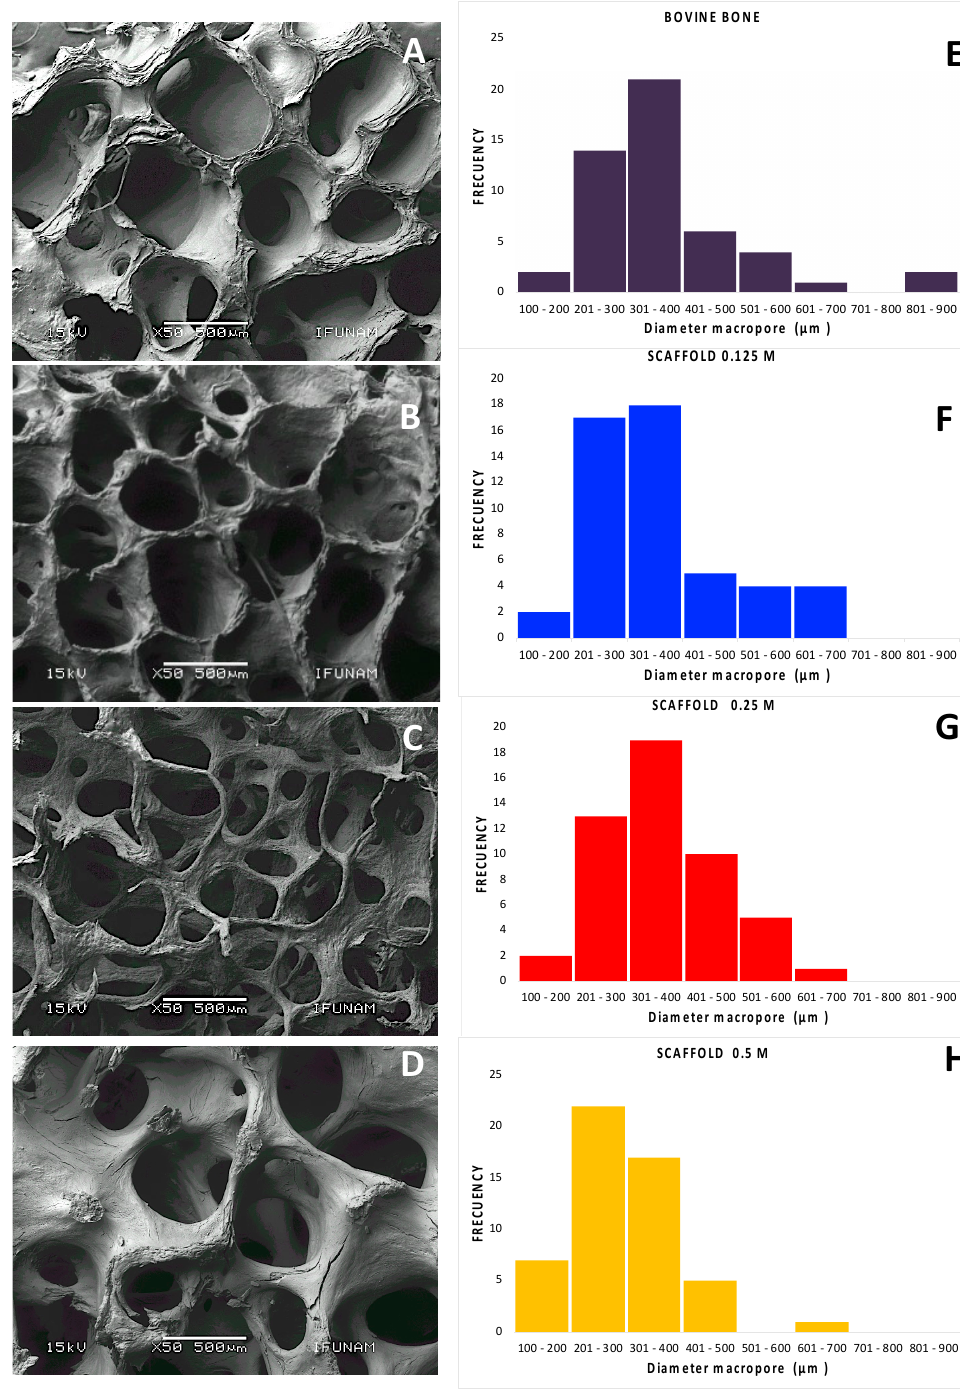
Figure 3. A-D SEM photomicrographs by the backscattered electron technique. The 0.125 M ( A ), 0.25 M ( B ), 0.5 M ( C ), and bovine bone ( D ). E–H Histogram of the pore size distribution determined by image J software. Diameter macropore is indicated as the equivalent larger macropores diameter observed in A – D , 0.125 M scaffolds were 356.69 μ m ± 125.36 ( E ), 0.25 M scaffolds were 352.82 μ m ± 96.65 ( F ), 0.5 M scaffolds were 300.08 μ m ± 94.96 ( G ), and the bovine bones without processing as control were 372 μ m ± 141.6 ( H ). Mag.: 50×, scale bar = 500 μ m.